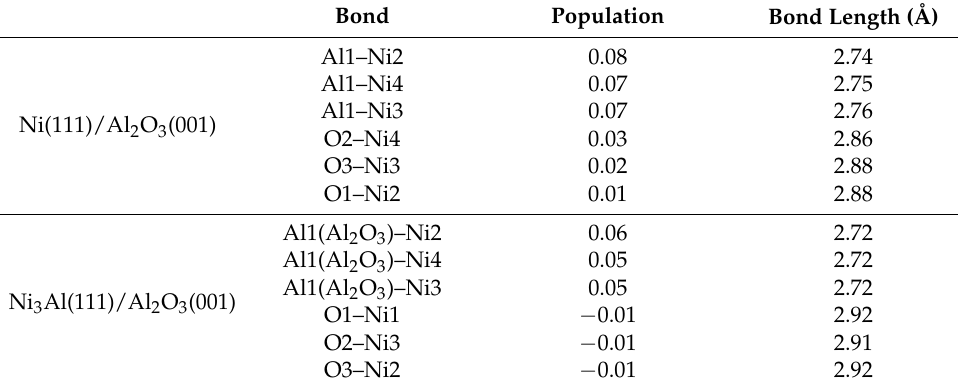
Figure 5. Atom numbers of the ( a ) Ni(111)/Al 2 O 3 (001) and ( b ) Ni 3 Al(111)/Al 2 O 3 (001) interfaces. The pink, red, and blue ball in figure shows Al, O, Ni atom separately. Table 3. Mulliken overlap population of the chemical bonds.